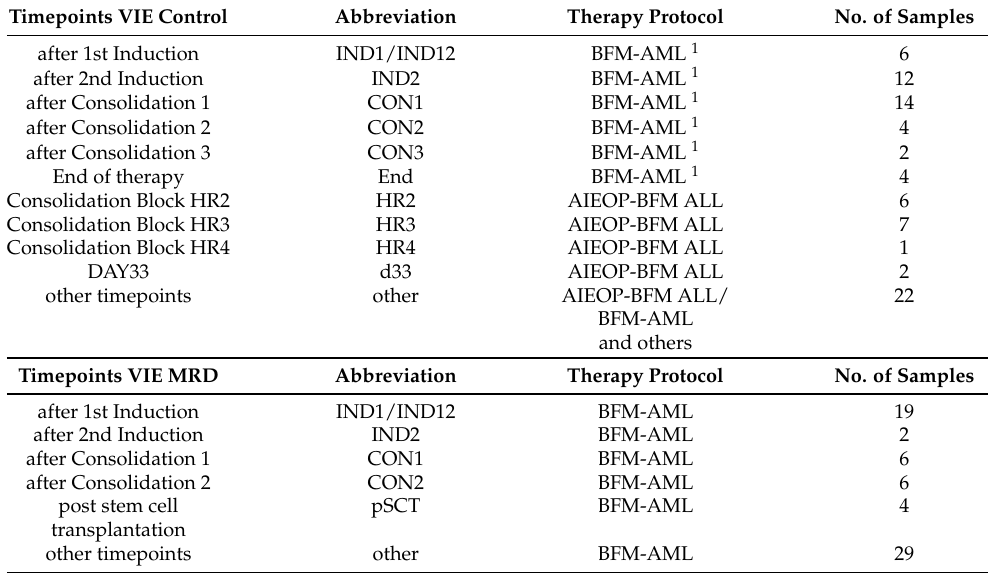
Table A2. Details on different timepoints of therapy that are present in the data set